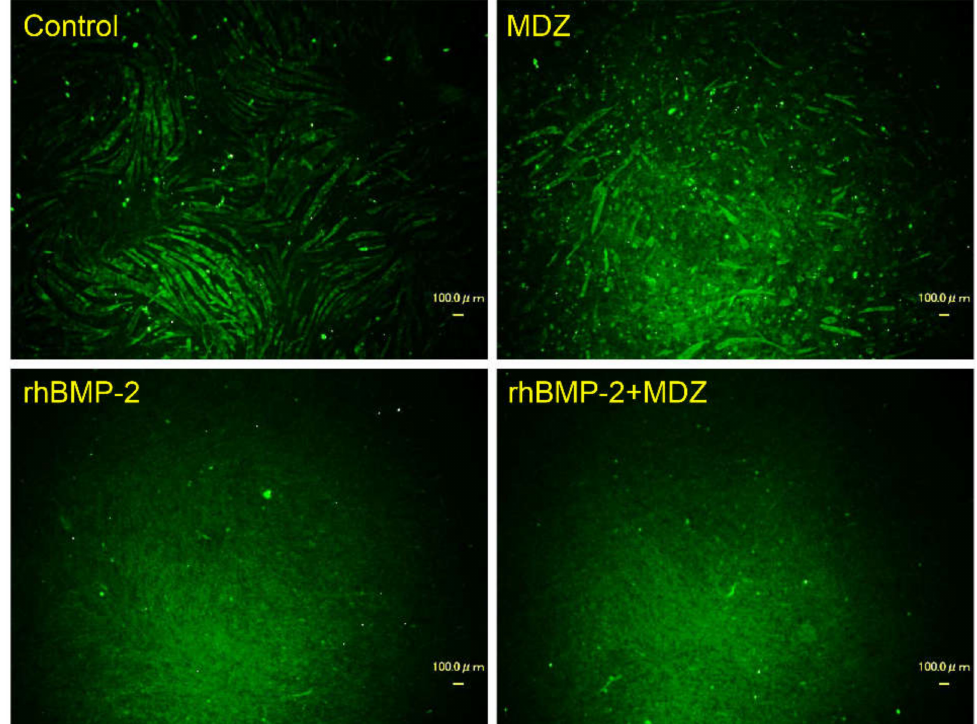
Figure 3. Combined e ff ect of MDZ and BMP-2 on the di ff erentiation of C2C12 cells. Fluorescence detection of Alexa Fluor ™ 488-labeled myosin skeletal heavy chain in C2C12 cells on day 10 following culture in the absence (Control) or presence of MDZ alone (MDZ), rhBMP-2 alone (rhBMP-2), and the combination of rhBMP-2 and MDZ (rhBMP-2 + MDZ). Myosin filaments (green) in fixed C2C12 cells were detected using an anti-fast myosin skeletal heavy chain antibody at a dilution of 1:400 and an Alexa Fluor TM 488 rabbit anti-mouse immunoglobulin G (IgG) heavy and light chains (H + L) cross-adsorbed secondary antibody at a dilution of 1:1000 (scale bar = 100 µ